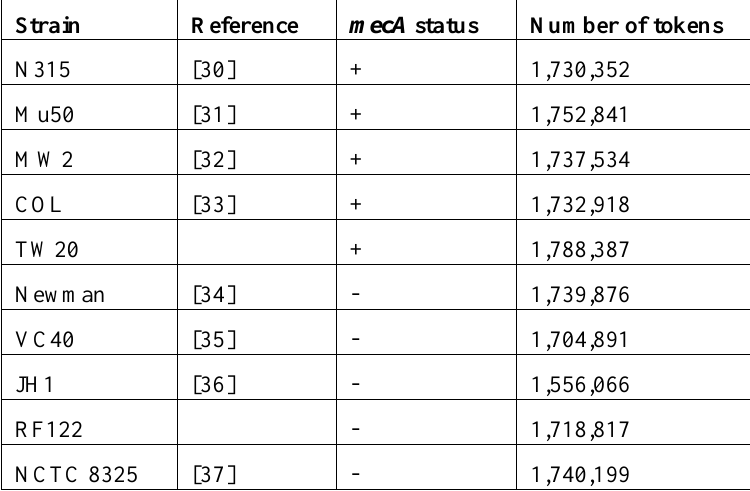
Tab. 2: List of mecA gene tokens present and absent in S. aureus strains. A total number of tokens of length 5 is specified for each strain.